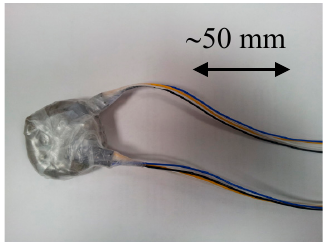
Figure 6. Hydrated bentonite block wrapped with RH sensors.